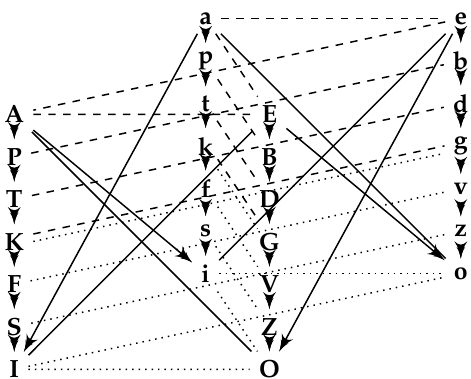
Figure A2. Graded Peterson’s cube of